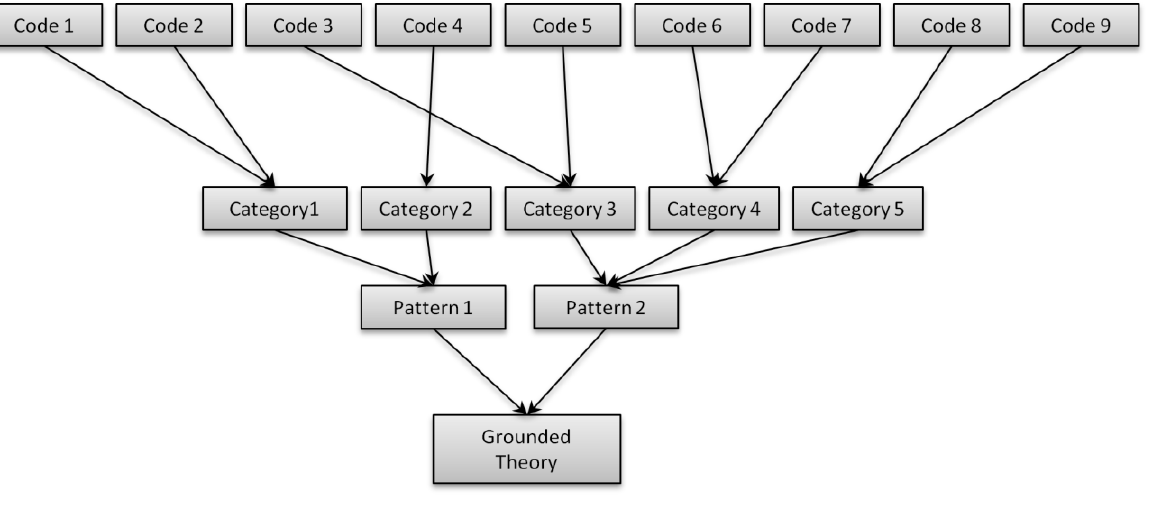
Figure 3: Workflow of Grounded Theory